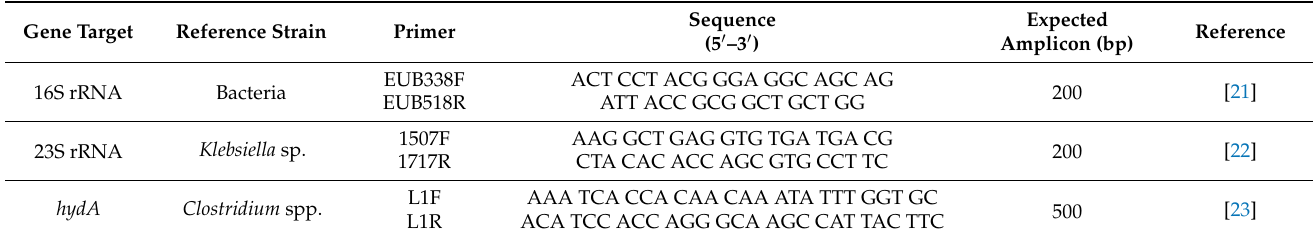
Table 1. Primer set used in the present study to quantify target